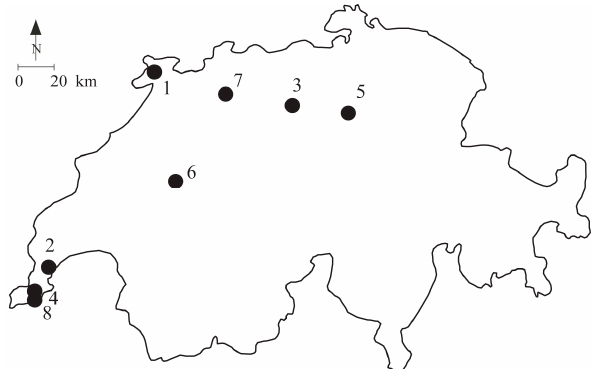
Figure 11. Map of Switzerland with the location of eight white earthenware manufactories: 1 Cornol (production start 1766), 2 Nyon (1790), 3 Lenzburg (1790), 4 Les Pâquis, Geneva (1791), 5 Kilchberg- Schooren, South of Zurich (1792), 6 Fribourg/Freiburg (1794), 7 Matzendorf (1798) and 8 Carouge (1803).